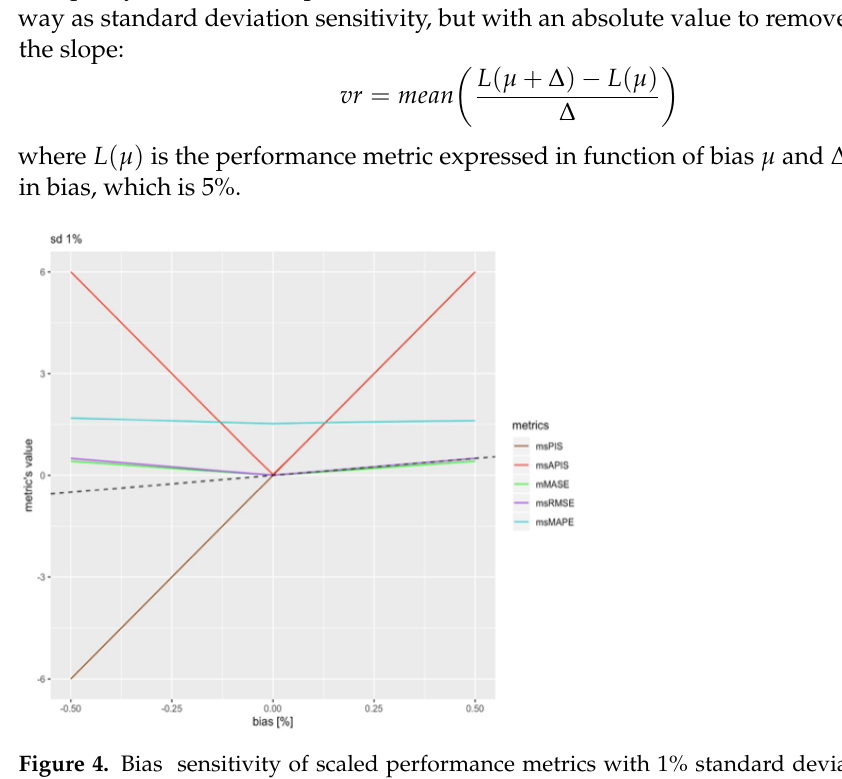
Figure 4. Bias sensitivity of scaled performance metrics with 1% standard deviation in forecast models.